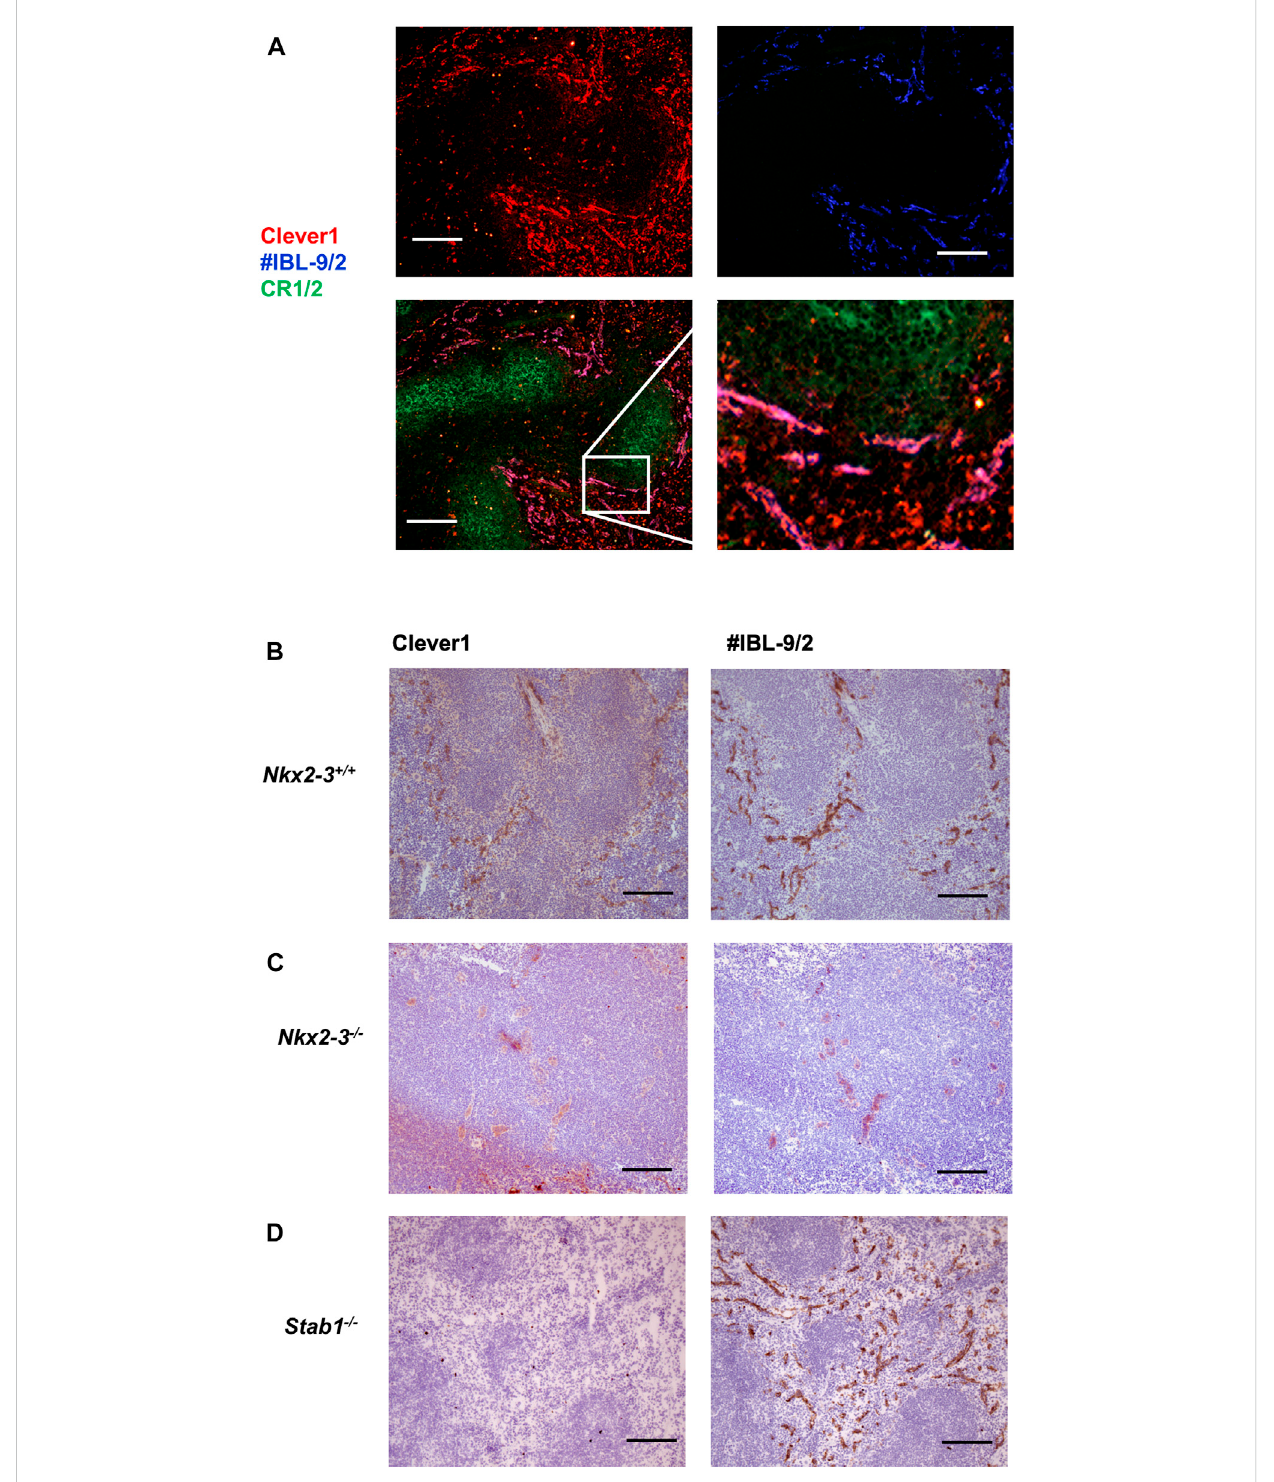
FIGURE 3 Nkx2-3 is necessary for the spleen red pulp vascular speci fi cation. Cryosections from C57Bl/6J mice were stained with the indicated antibodies, demonstratingco-localizationofClever1(red)andIBL-9/2(blue)staining(top)with relationto whitepulpfolliculardendriticmeshwork(CR1/2,green)to visualizefollicles(bottom,left)inwild-typespleen.InsetofthemergedimagedemonstratesthevascularoverlapbetweenClever1andIBL-9/2markersas purple (A) .Inwild-typemice (B) bothClever1andIBL-9/2labelingarepresent,whereastheabsenceofNkx2-3leadstotheabsenceofbothmarkers (C) ;incontrast,thedeletionofStab1onlyabolishesClever1expression (D) .Representativeimages,experimentrepeatedtwice, n =4,scalebar=100 µm.